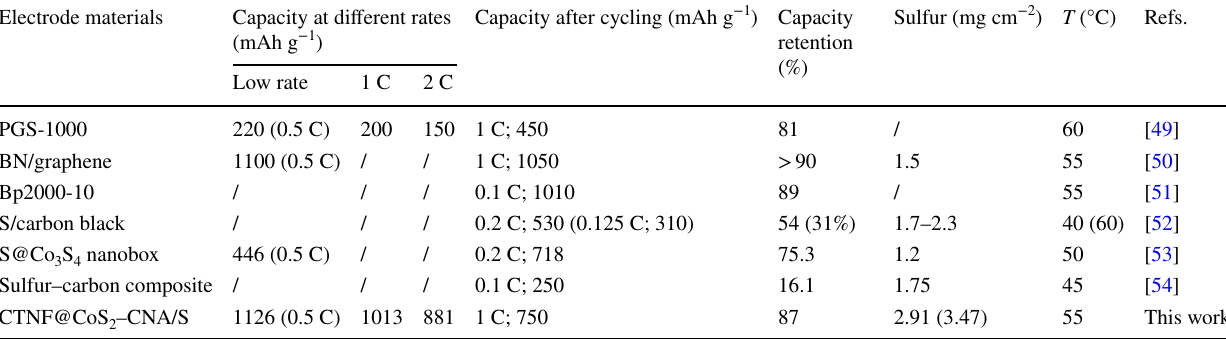
Table 1 Comparison of electrochemical performance with previously reported sulfur-based cathodes in LSBs at high temperature Electrode materials Capacity at different rates (mAh g −1